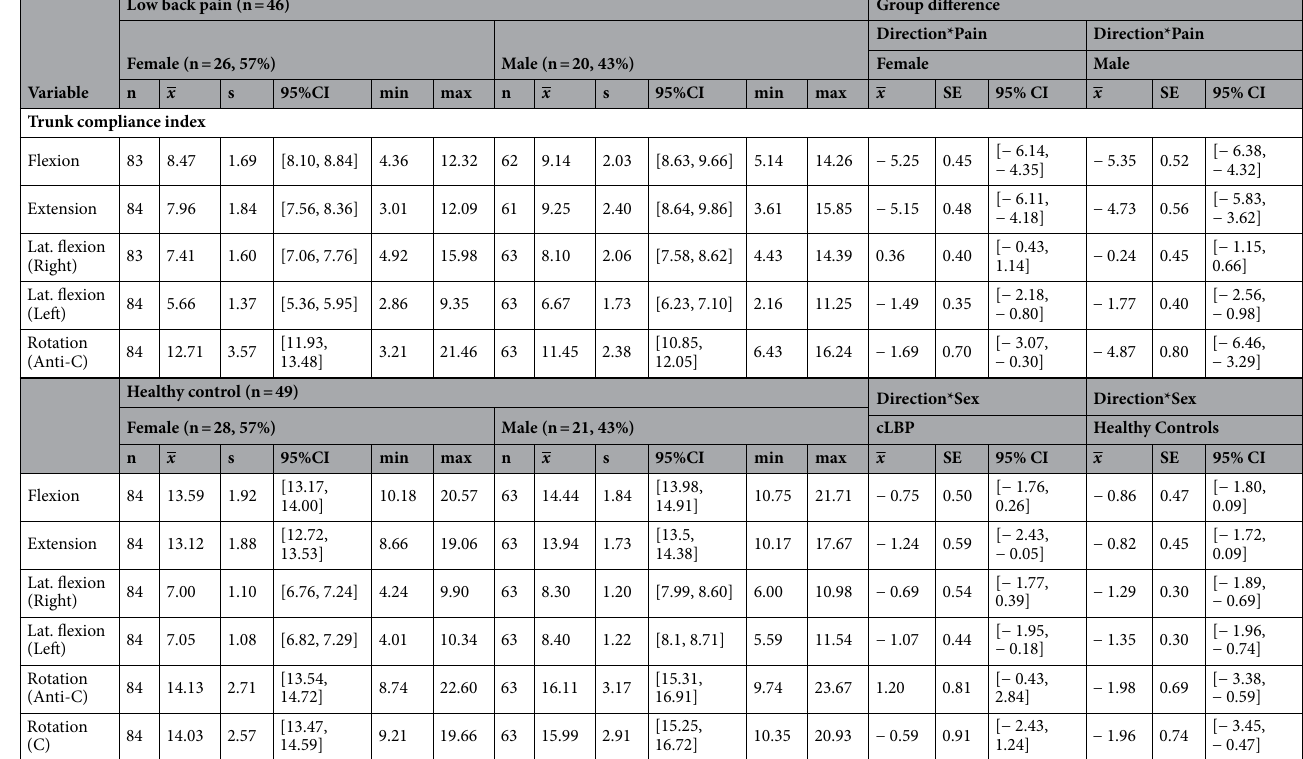
Table 2. Comparison of Trunk Compliance Index between pain condition and